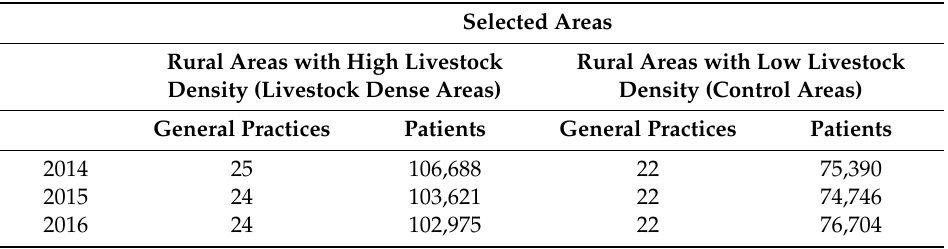
Table A1. Overview of the total sample in the livestock dense areas and control